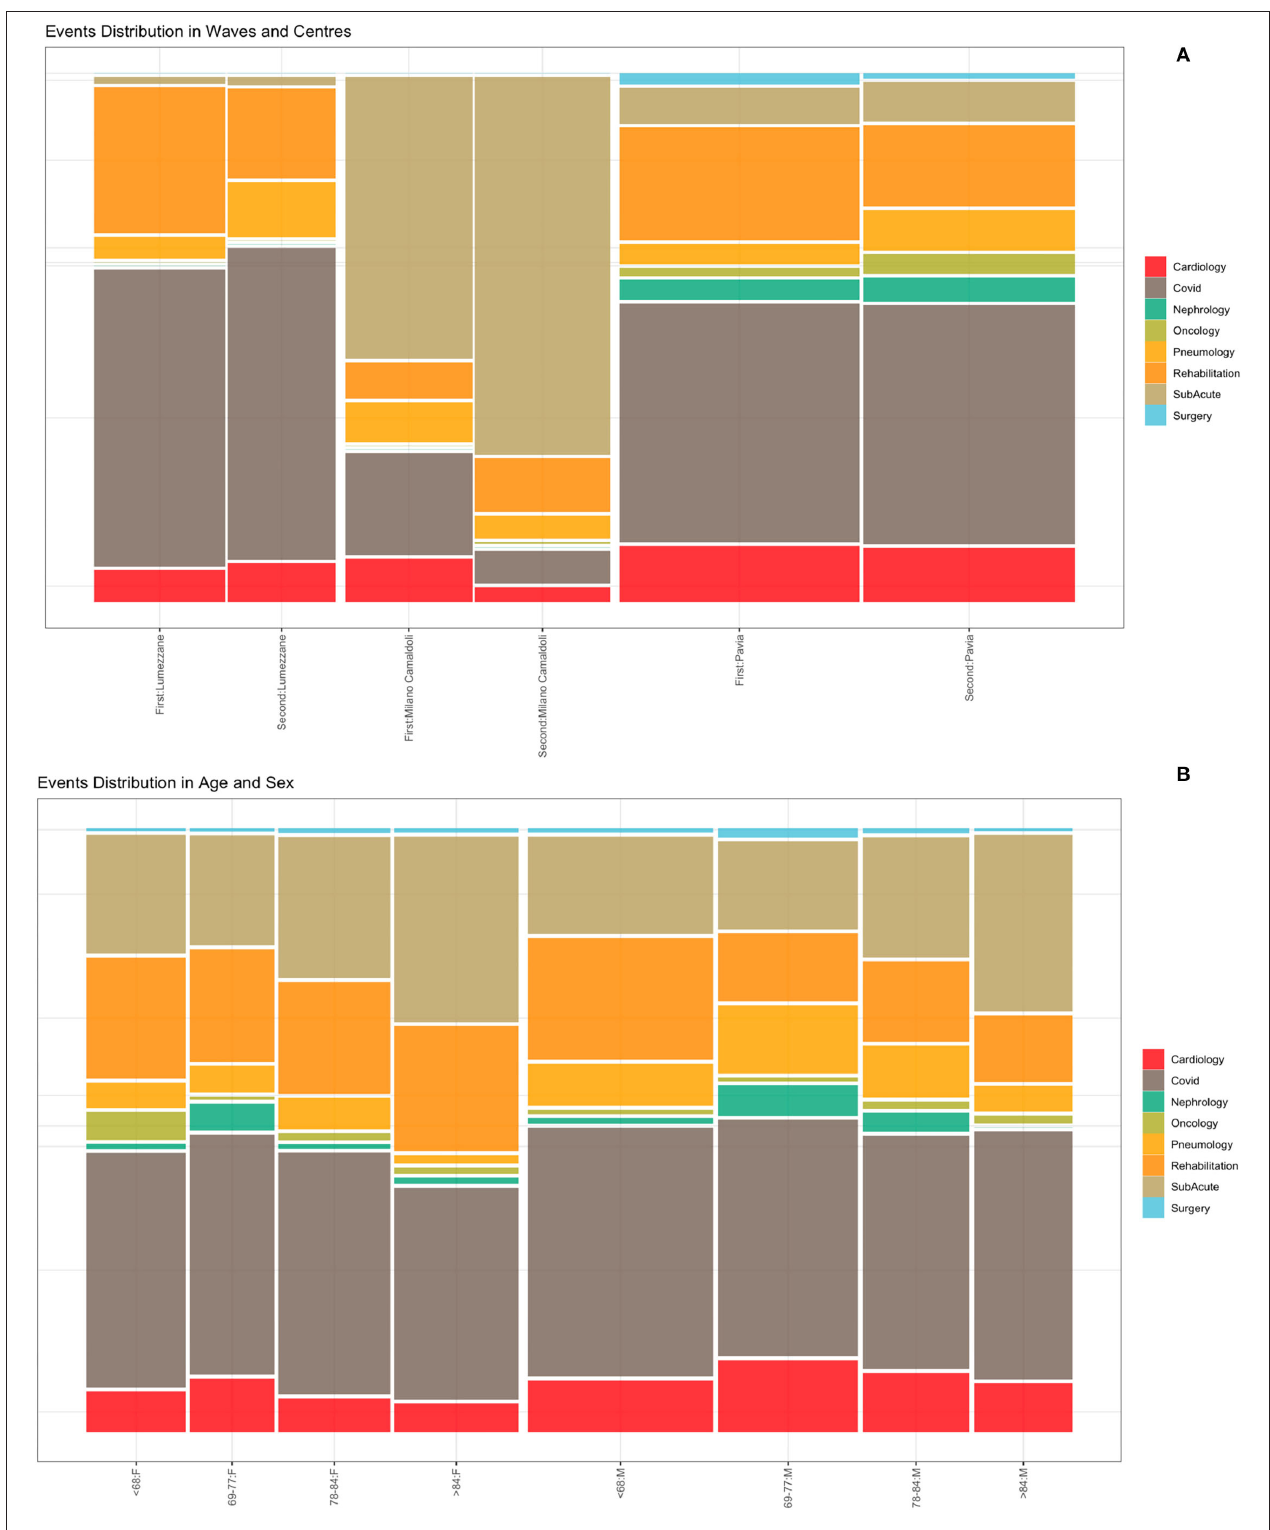
FIGURE 5 | Events distribution by waves and centers (A) and by age and sex classes (B) . Events consist of hospitalizations.